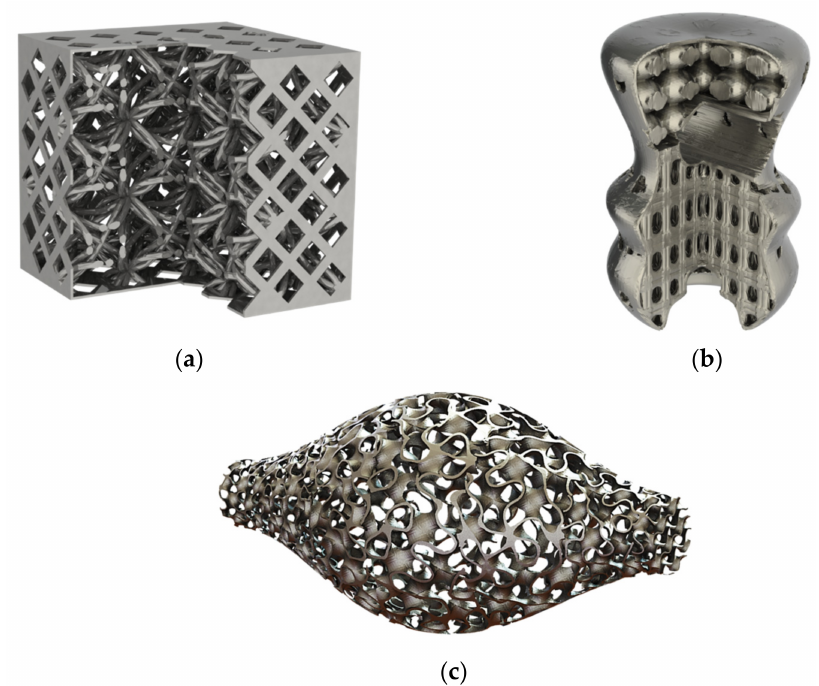
Figure 6. Shell generation and perforation: ( a ) Cubic shell perforated with a diamond pattern and filled with the artistic unit cell, ( b ) spline-based revolved shell perforated with a circular pattern and filled with multi-domain sized graded unit cells, and ( c ) two-step size graded gyroid shell for a sinusoidal revolved